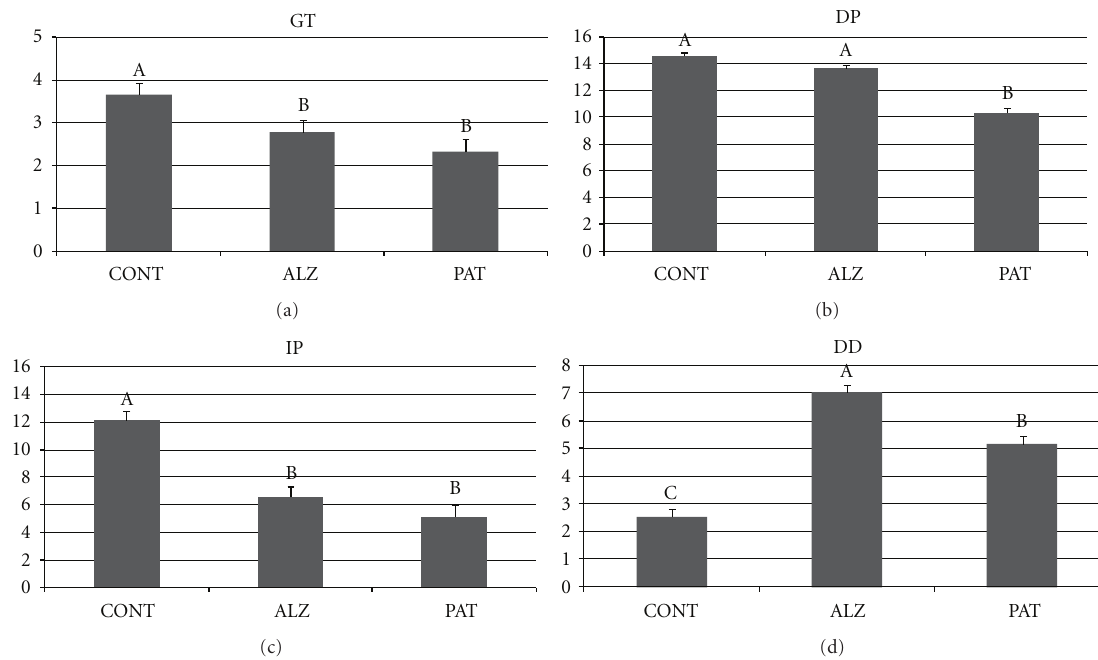
Figure 2: Means and standard errors of scores for gas threshold (GT), supraliminal detection (DP), identification (IP), and their di ff erence (DD) across the 3 groups of study 2 (CONT: control elderly group, ALZ: Alzheimer’s patients, PAT: smell clinic patients). Bars with the same letter do not di ff er